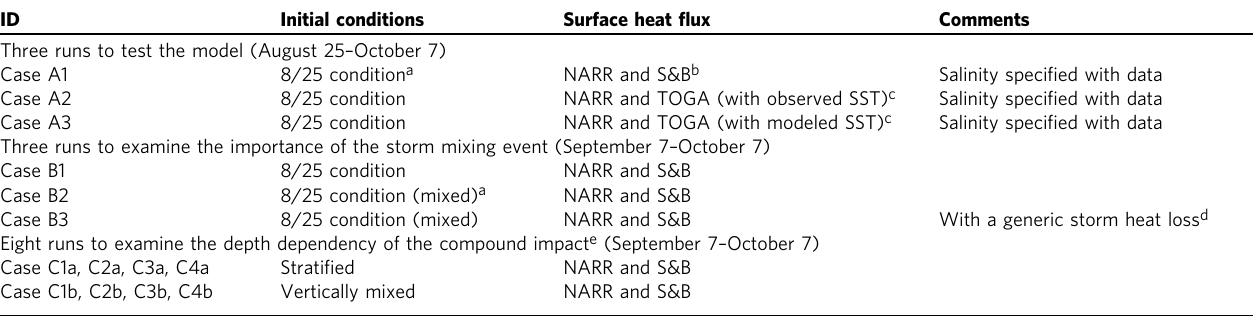
Table 1 Design of model runs.